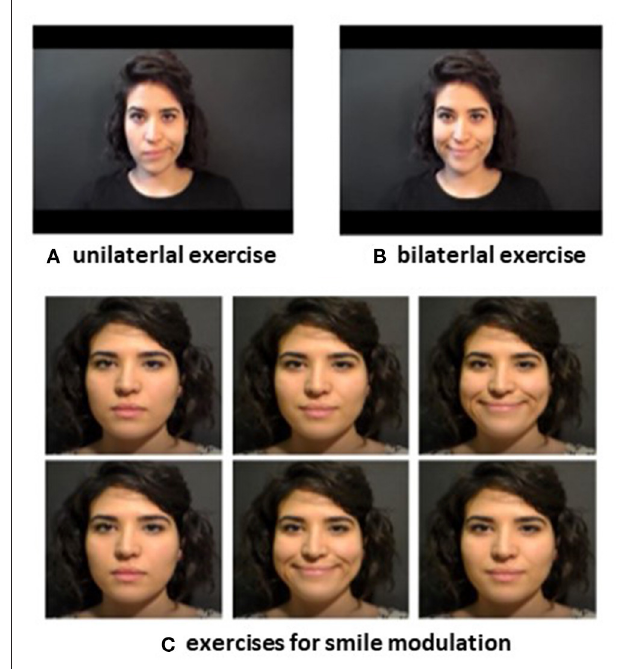
FIGURE 1 | FIT-SAT protocol consists in an action-observation protocol and it includes videos in which an actor performs smiles (facial imitation treatment, FIT) and provides instructions concerning both the co-activation of hand closed as a fist (synergistic activity treatment, SAT) and the number of repetitions that the patients will perform. Specifically, the FIT-SAT protocol consists in two phases: unilateral and bilateral phases. In unilateral phase the goal is to support patients in recruiting the transplanted muscle through unilateral exercises. The first unilateral phase starts about 8 weeks after the surgery, when the patients begin to recruit the transplanted muscle. It consists in the observation of a 3s smile produced by an actor on a video and the instruction for the subsequent patient’s synergetic hand-mouth contraction (A) . The task of the patients is to imitate the actor’s smile and, while they are smiling, simultaneously clench their fist. Each patient starts the daily session with five repetitions repeated for three times. Progressively, further repetitions are gradually included until the patient is able to perform at least ten successive repetitions and to maintain the posture for at least 3s. This second phase starts after a clinical evaluation performed by the speech therapist who assesses the patient’s ability to recruit the muscle without hand contraction. In the bilateral phase the goal is to achieve a symmetric smile and to be capable to modulate it through bilateral exercises (B) . Bilateral exercises include modulation tasks in which the patient is asked to perform maximum and small (gentle) smiles in order to train and control the contraction force of the transplanted muscle/s (C)